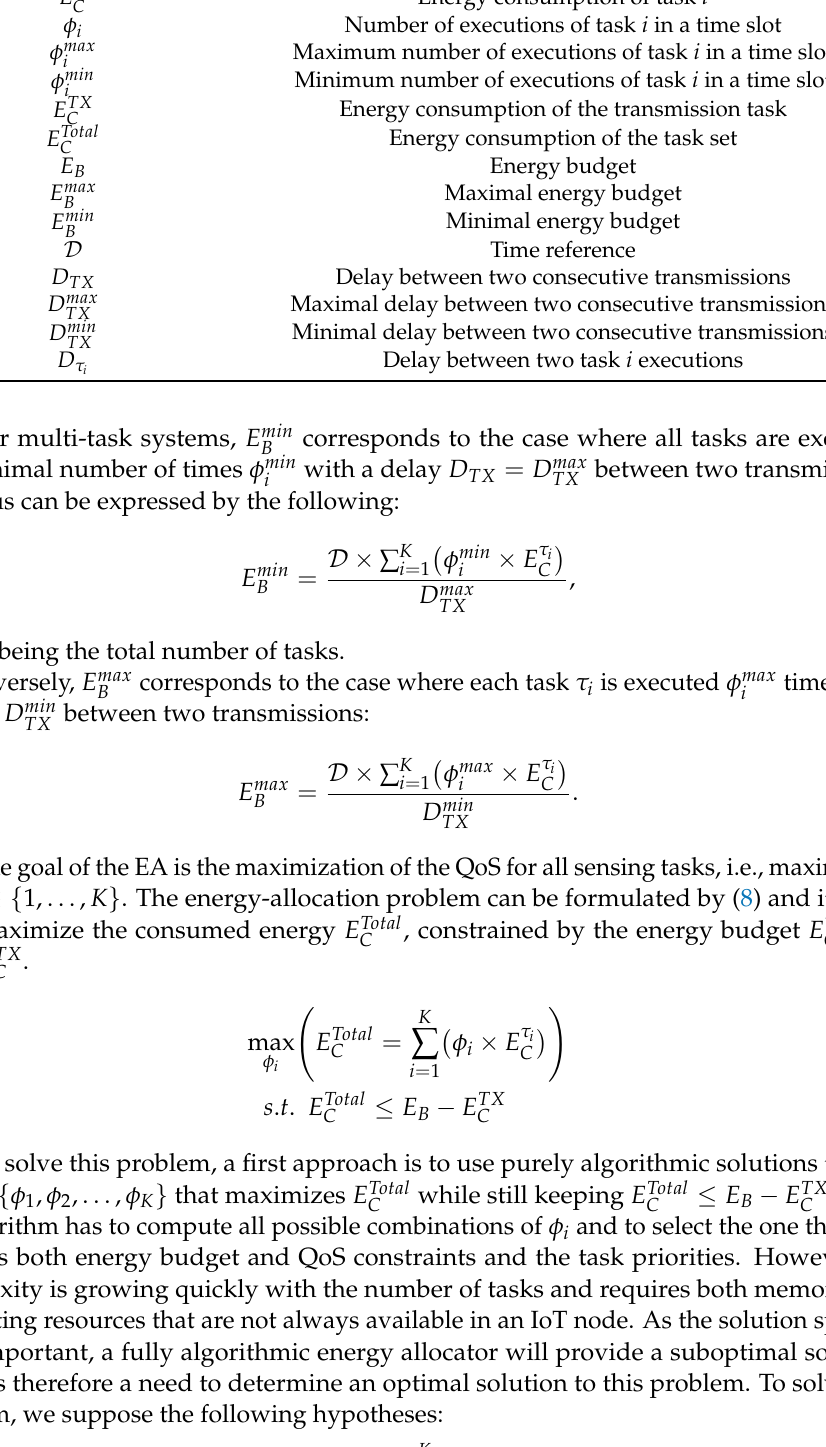
Priority of task